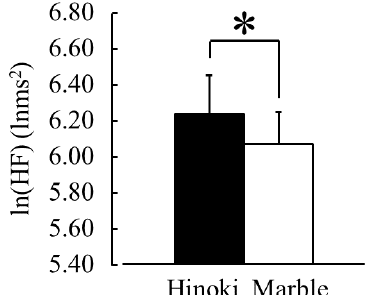
Figure 6. The natural logarithm of the high-frequency power component of heart rate variability during contact with materials via the soles of the feet. n = 19, mean ± SE, * p < 0.05 (Hinoki vs. marble) as determined by using a paired t -test.